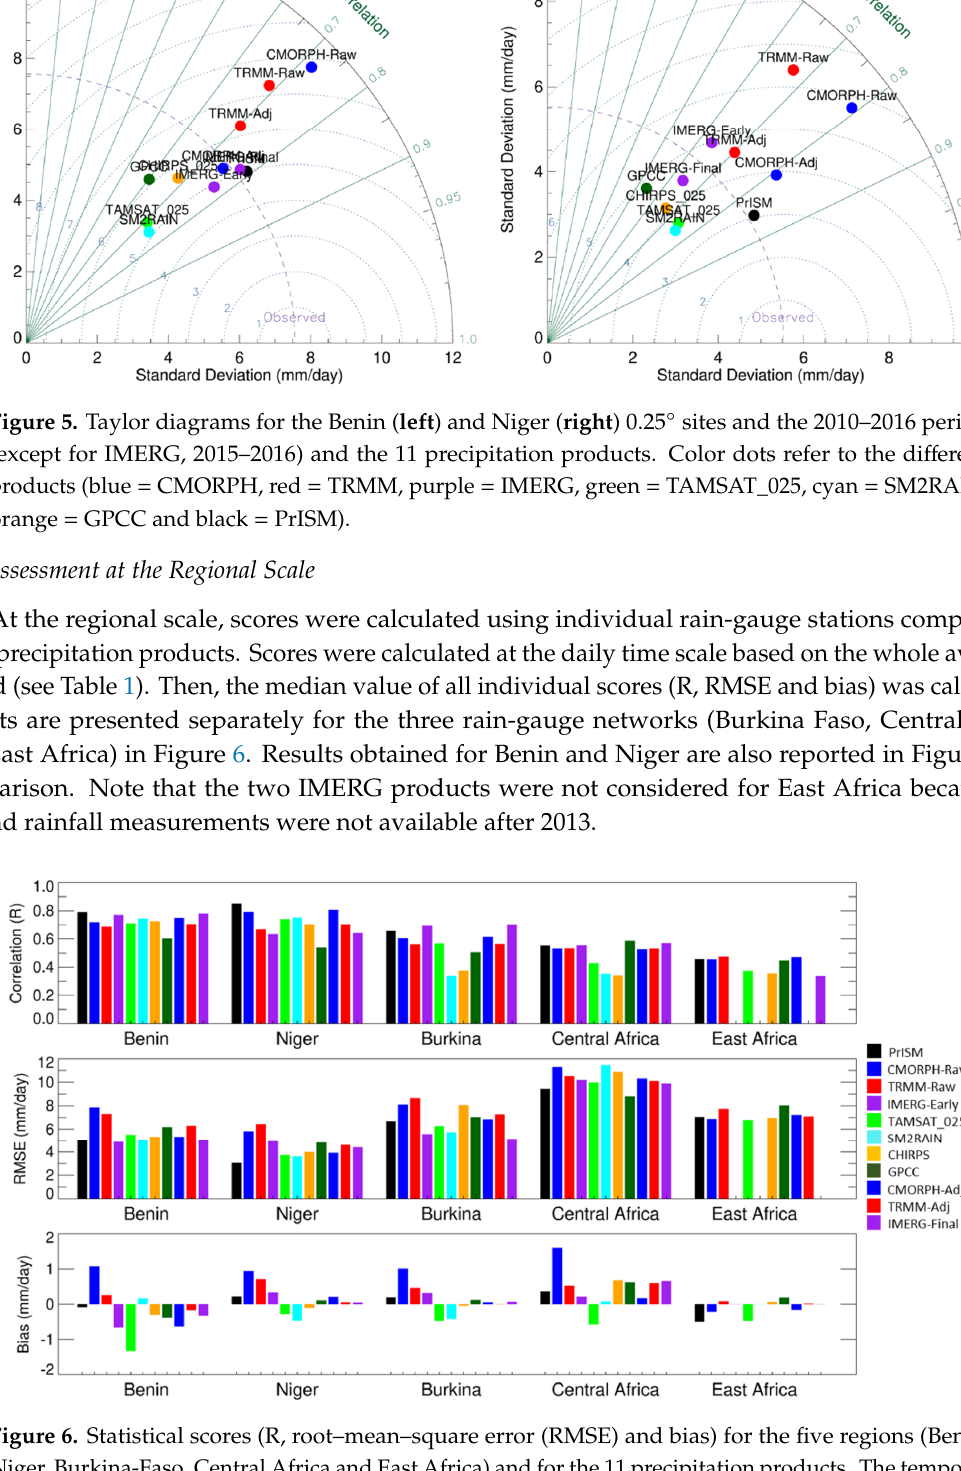
12 of 18 Figure 4. Taylor diagrams for the Benin ( left ) and Niger ( right ) 0.25° sites for the year 2015 for the 11 precipitation products. Color dots refer to the different products (blue = CMORPH, red = TRMM, purple = IMERG, green = TAMSAT_025, cyan = SM2RAIN, orange = CHIRPS, dark green = GPCC and black = PrISM). Statistical scores are given in Table 3. Lastly, the Taylor diagrams were plotted for the whole period (2010–2016, instead of 2015) except for the two IMERG and SM2RAIN precipitation products, which start in March 2014 and are then considered only for 2015–2016 period. Figure 5 reveals some slight differences compared to Figure 4